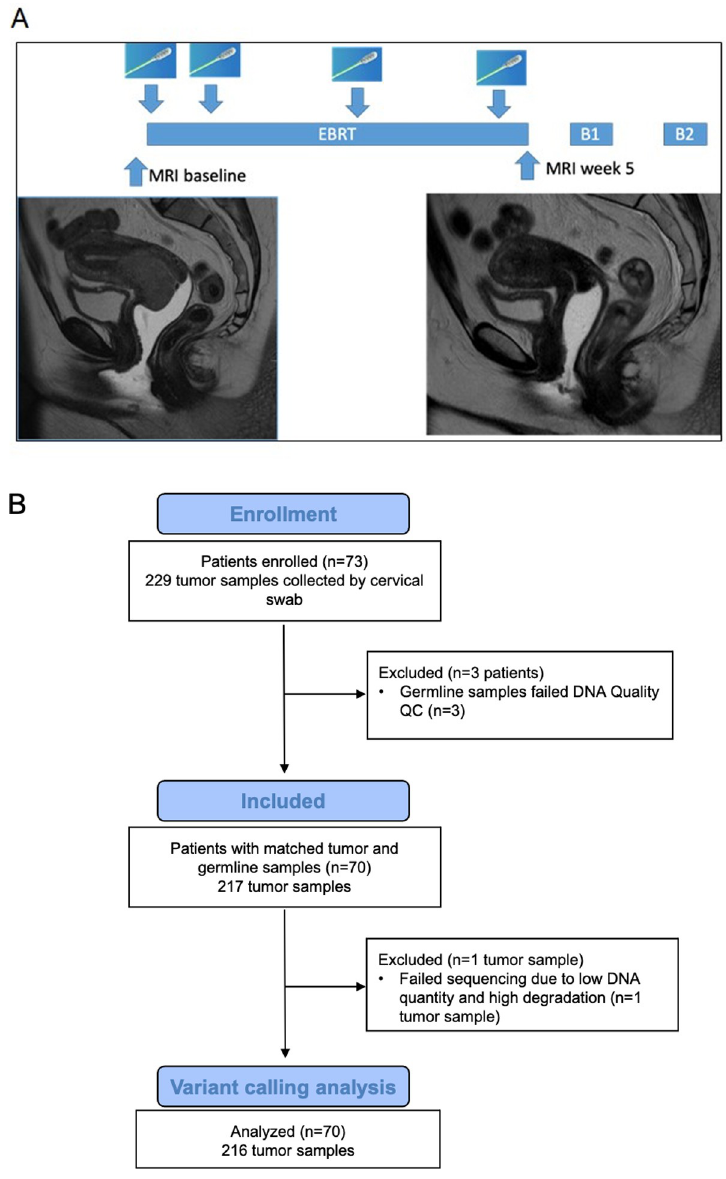
Fig 1. Overall study design and CONSORT diagram. (A) Patients with cervical cancer underwent five weeks of external beam radiation therapy (EBRT) followed by two brachytherapy treatments (B1 and B2), with swab samples collected at baseline, week 1, week 3, and week 5 of radiation therapy as well as week 12 (after completion of radiation therapy). (B) Of the 73 patients accrued on protocol, 70 patients with 217 total samples had DNA of adequate quantity and quality for sequencing. One tumor sample failed sequencing due to low quantity and high degradation and was not included in the analysis.